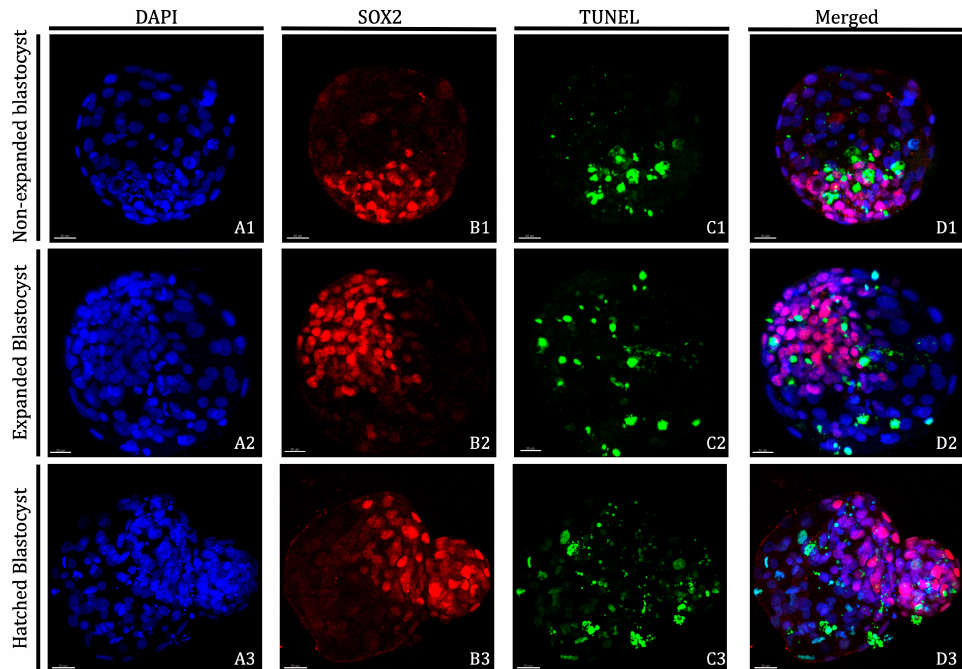
Figure 1. Representative images of D8 non-expanded, expanded and hatched blastocysts derived from vitrified/warmed oocytes in vitro matured in the presence of 25 ng/mL of LIF. Nuclei counterstained with DAPI are displayed in blue ( A1 – A3 ), Inner Cell Mass is displayed in red ( B1 – B3 ) and TUNEL-positive cells are displayed in green ( C1 – C3 ). Overlayed images are presented in D1 – D3 . Non-expanded blastocysts: A1 , B1 , C1 , and D1 ; Expanded blastocysts: A2 , B2 , C2 and D2 ; and Hatched blastocysts: A3 , B3 , C3 and D3 . Scale bar: 30 μ m. DAPI (406-diamidino-2-phenylindole), TUNEL (Terminal deoxynucleotidyl transferase dUTP nick end labelling).